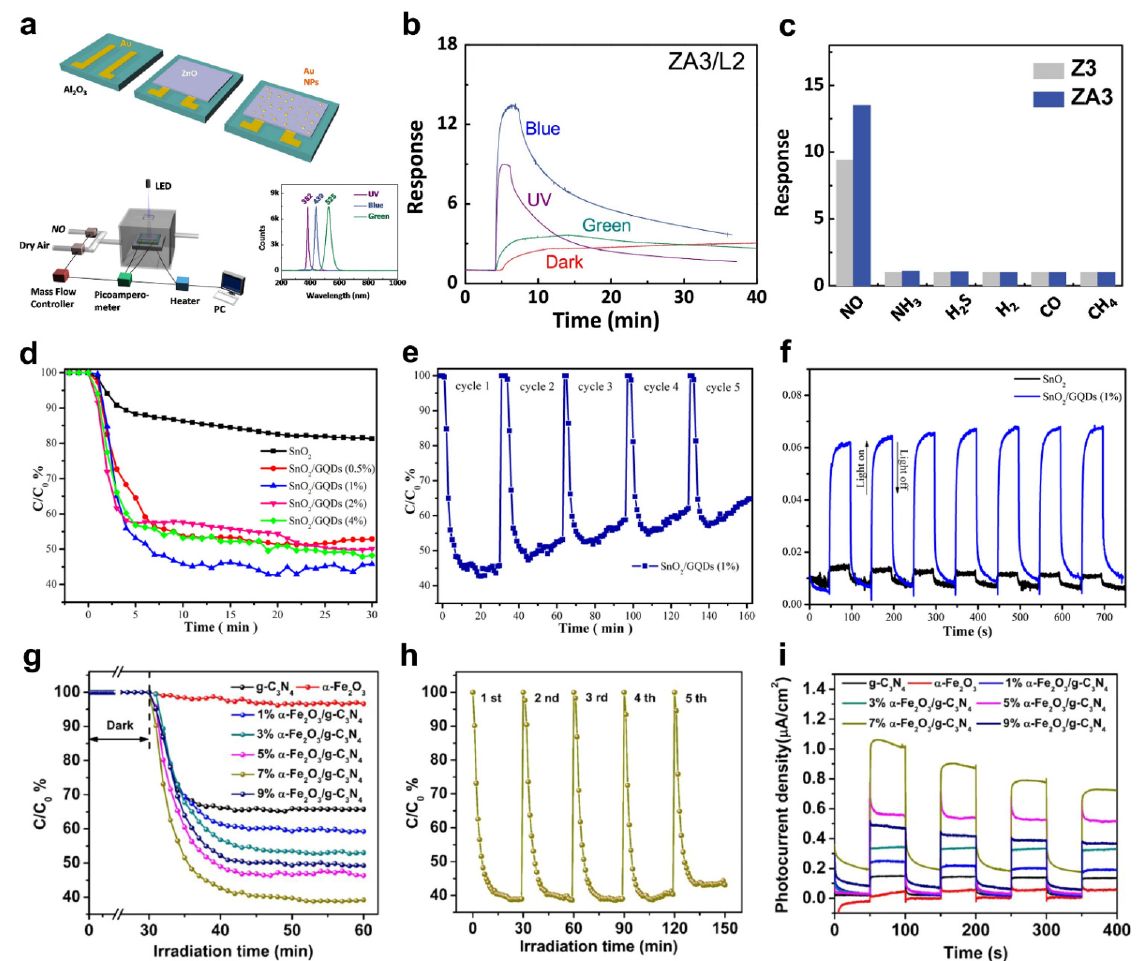
Figure 6. ( a ) Fabrication process of the Au/ZnO gas sensor; ( b ) response of the Au/ZnO gas sensor with various light irradiation (UV, blue, green); ( c ) selectivity characteristics of the Au/ZnO gas sensor (adapted from [96] with permission from the Elsevier B.V.); ( d ) photocatalytic spectrum of SnO 2 /GQDs under visible light irradiation; ( e ) recycling test for of SnO 2 /GQDs with visible light irradiation; ( f ) photocurrent density of the pure SnO 2 and SnO 2 /GQDs (adapted from [97] with permission from the Elsevier B.V.); ( g ) photocatalytic performances of α− Fe 2 O 3 /g − C 3 N 4 sensors with different composite ratios in removing NO gas; ( h ) recycling test for 7% SnO 2 /GQDs sensor with visible light irradiation; ( i ) photocurrent response of pure α− Fe 2 O 3, g − C 3 N 4, and α− Fe 2 O 3 /g − C 3 N 4 (adapted from [98] with permission from the Elsevier B.V.).